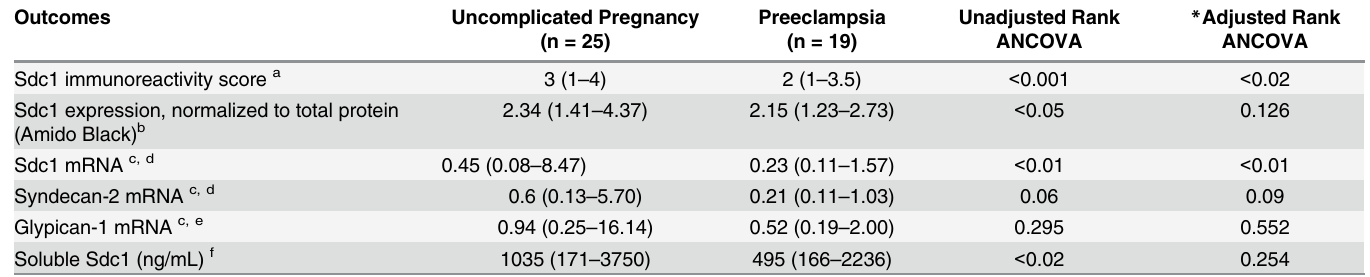
Table 3. Placental and pre-delivery plasma data, corresponding to the uncomplicated pregnancy (n = 25) and preeclampsia (n = 19) groups described in Supplementary S4 Table.